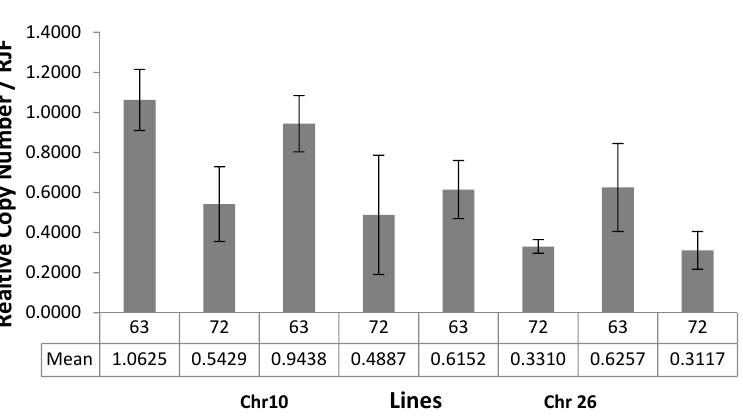
Figure 5. Quantitative PCR was performed on two Line 72 lineage-specific deletion CNVs (chr10:5,716,844–571,784,053 and chr26:1,927,477–1,931,663) using two independent primers per